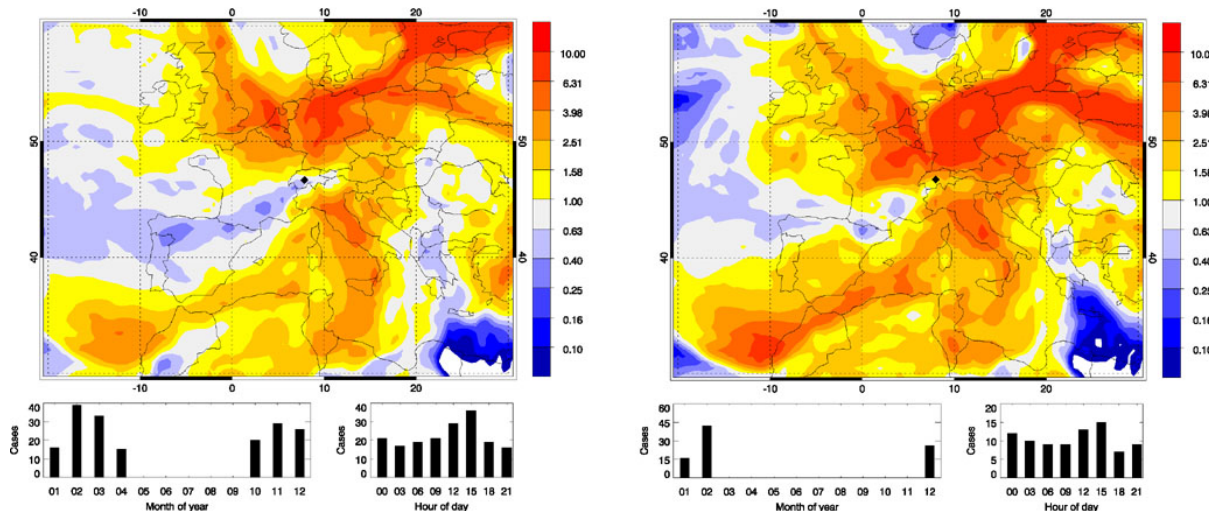
Fig. 11. Relative footprint maps for the situation with high CO 2 and low O 2 (subset 2). The left panel represents the relative footprint map for year round values whereas the right panel shows the winter only selection. The trajectories are mainly coming from Northeastern Europe with increased residence times over Northern Germany and Eastern European Countries (yellowish and reddish colours) See Fig. 10 for further